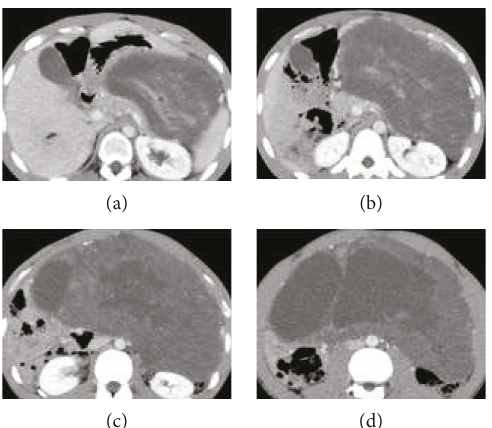
Figure 1: (a – d) CT scan with intravenous contrast (sagittal view): the tumor seemed to be divided into two parts. The right part was like a single cystic lesion; the left part contained a solid component.